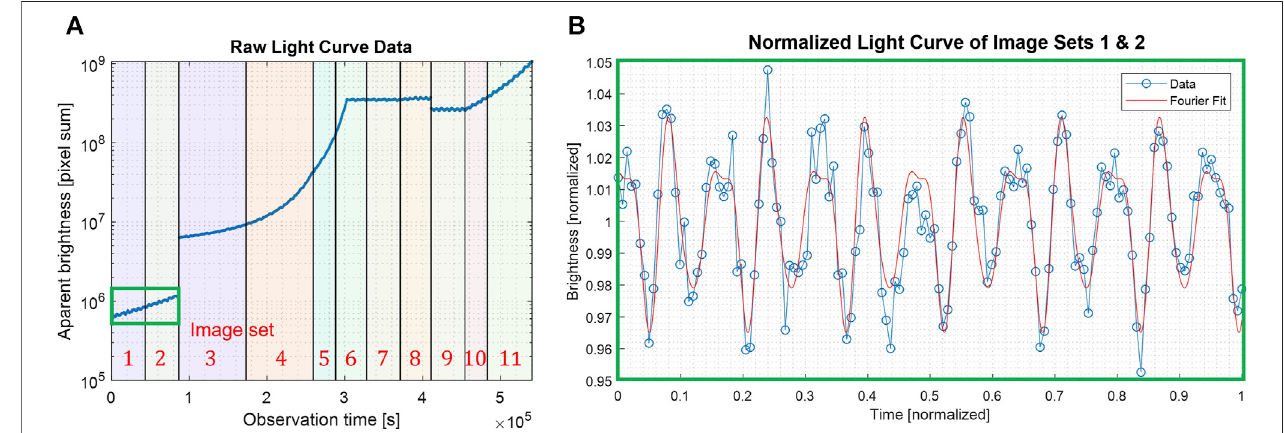
FIGURE10| Periodicityanalysisoftheexperiment. (A) Rawlightcurveshowinggeneralincreaseinbrightnessduringapproachanddiscontinuitiesassociatedwith maneuvers and changing exposure settings. (B) Periodicity analysis of the light curve from image sets 1 and 2 only. After normalization, a 4th order Fourier fi t estimates the period to be P (cid:2) 3.728 ± 0.006